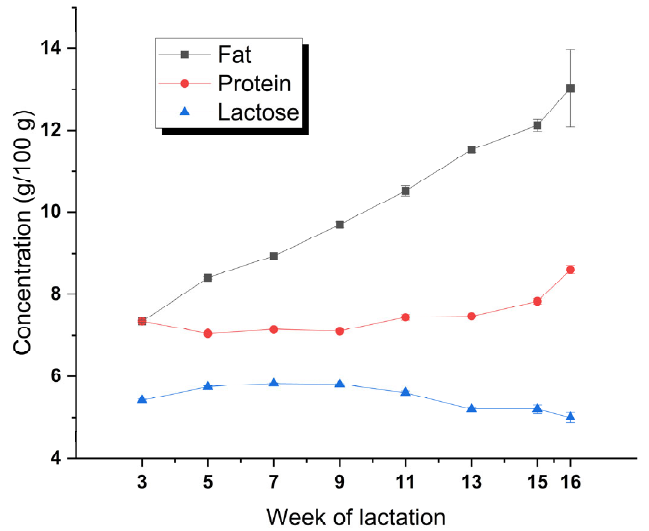
Figure 1. Variations in the fat, protein, and lactose contents of deer milk over the lactation.